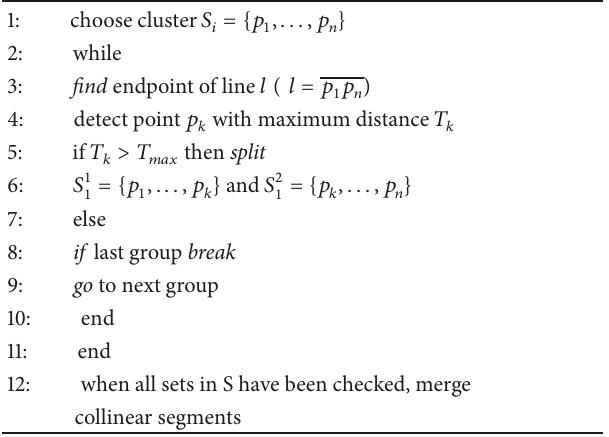
Table 2: Pseudocode of the Iterative Endpoint Fit